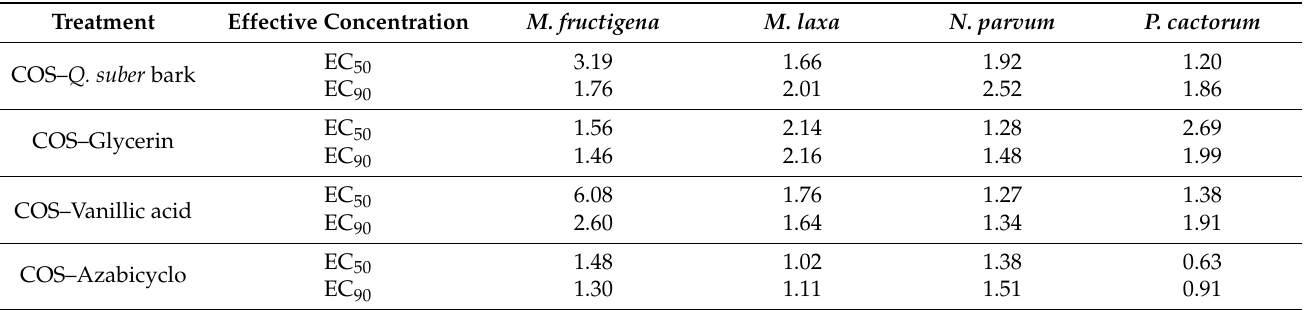
Table 2. Synergy factors for the conjugate complexes estimated according to Wadley’s